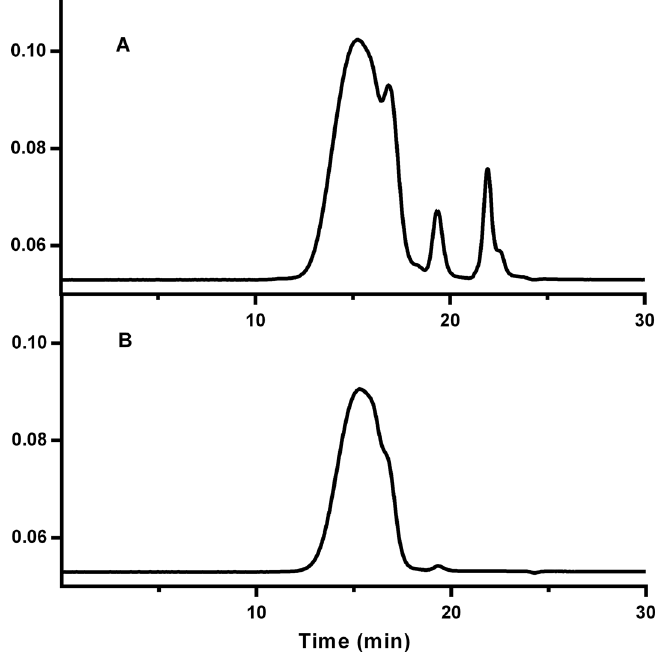
Fig 3. Absorbance profile (280 nm) of analytical HPLC of Pfs25M-EPA using a G5000PWxl column (Toso Biosciences); A) before purification and B) after purification. The Y axis represents detector voltage.